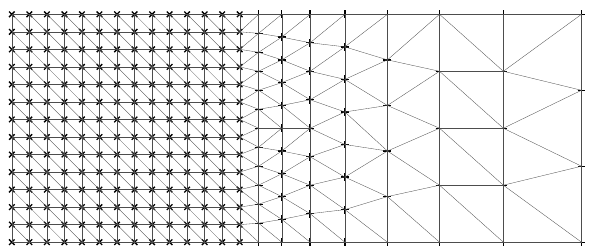
Figure 3. Graded mesh with high resolution in the region of interest (marked with ) and bu ↵ er space towards the boundary ⇥ (marked with +